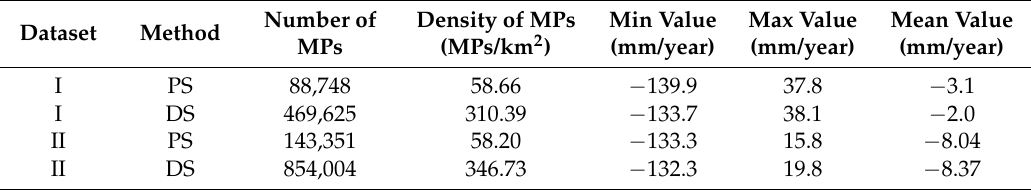
Figure 6. Statistical histogram of measuring points (MPs) of Zone B and Zone C. The statistical analysis is based on the persistant scatterer interferometry using Dataset II. Table 3. Statistics of MPs of the PS and DS approaches.